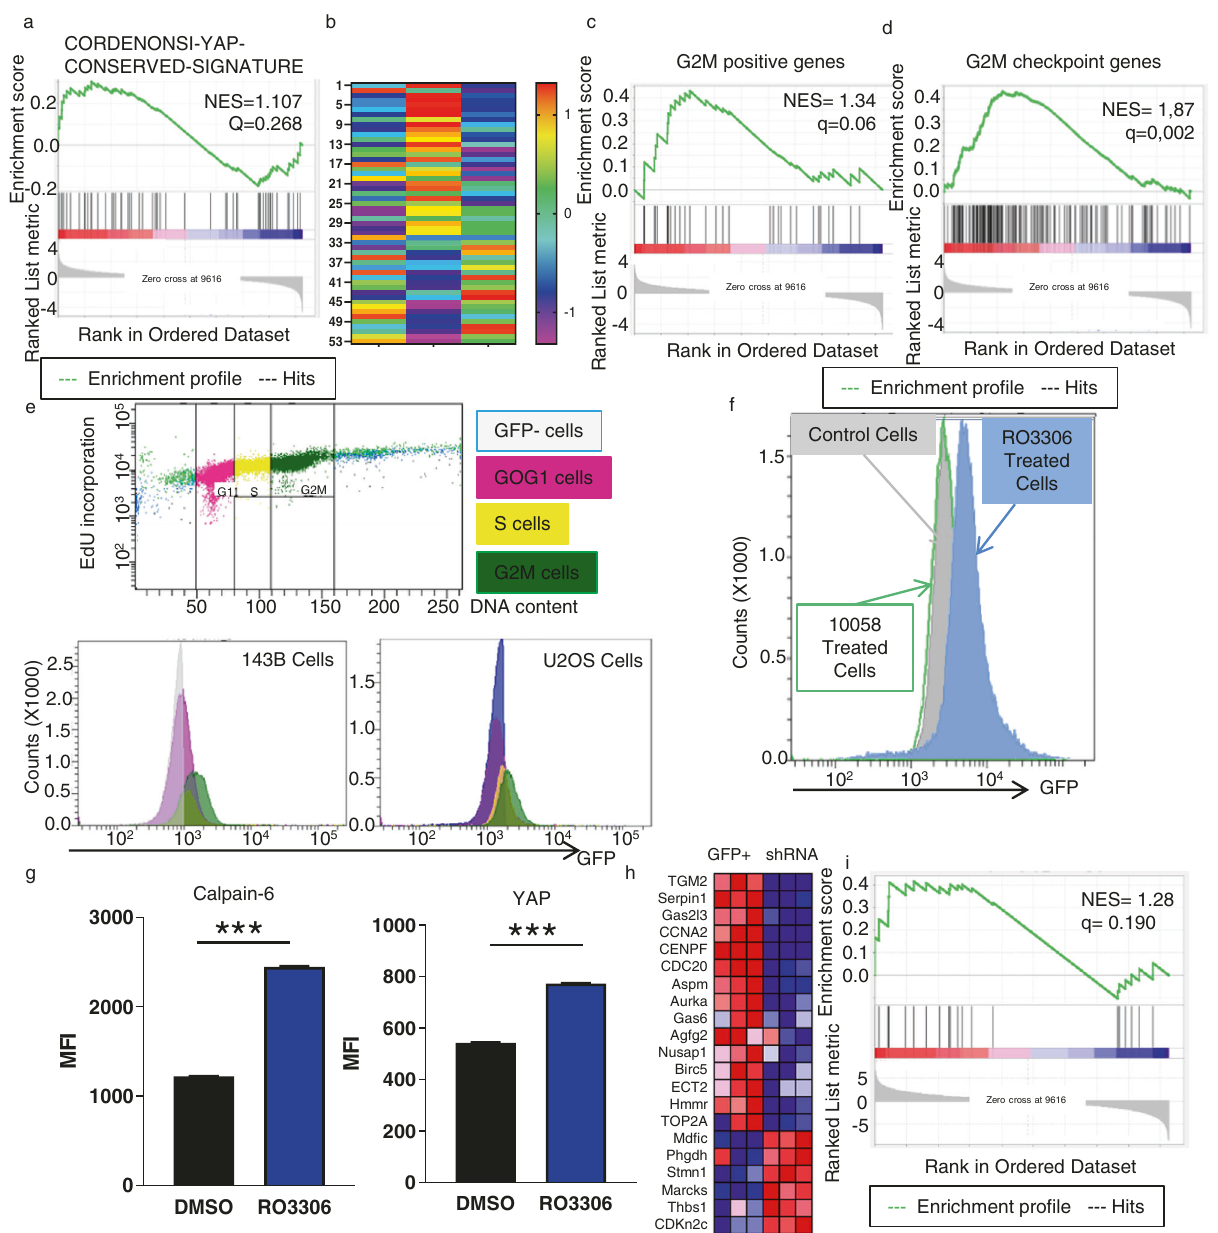
Fig. 4 Calpain-6 – dependent promotion of YAP protein is associated with the G2M phase. a Analysis of the CORDENONSI_YAP_CON- SERVED_ SIGNATURE in Calp6-P-GFP + vs Calp6 shRNA cells. b Heat map showing the CORDENONSI_YAP_CONSERVED_ SIGNATURE in calpain-6 – overexpressing (Calp6 + ), Calp6-P-GFP + (GFP + ) and Calp6 shRNA – expressing cells (Calp6 shRNA). c , d , Gene set enrichment analysis of G2M-positive and G2-checkpoint gene signatures comparing Calp6-P-GFP + and Calp6 shRNA cells. NES is normalized enrichment score. e Flow cytometry of expression of GFP in Calp6-P-GFP cells during the cell cycle. Analysis of DNA content and Edu incorporation to select cells in the different phases of the cycle and GFP fl uorescence intensity in different sorted cell populations. Color code for dots and histograms: Pink = G1, yellow = S, Green = G2M. Grey or blue histograms are negative controls. f GFP fl uorescence in Calp6-P-GFP cells that were blocked in G1 (10058 treated cells, green histograms), in G2 (R03306 treated cells, blue histograms) and in control cells (grey histograms). g Calpain-6 and YAP labeling in control or G2M-blocked (RO3306) cells. Results are mean ± SEM fl uorescence intensity (MFI). 45000 cells were analyzed. *** p < 0.001. h Heat map of the differential expression of YAP-dependent mitotic genes in Calp6-P-GFP + and Calp6 shRNA cells. i , Mitotic gene enrichment analysis comparing Calp6-P-GFP + to Calp6 shRNA cells. h , i , From t h e left, the list of the genes, heat map of gene expression and enrichment